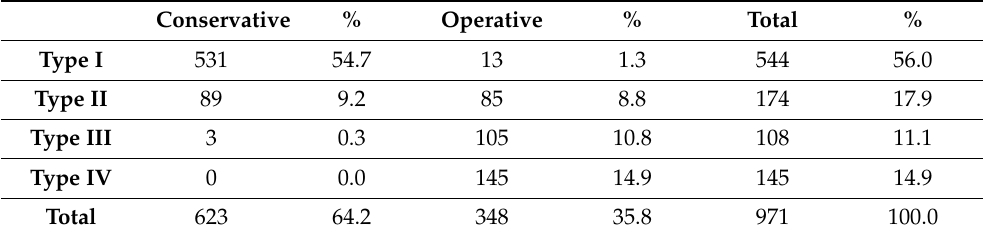
Table 3. Treatment modality according to fracture types.